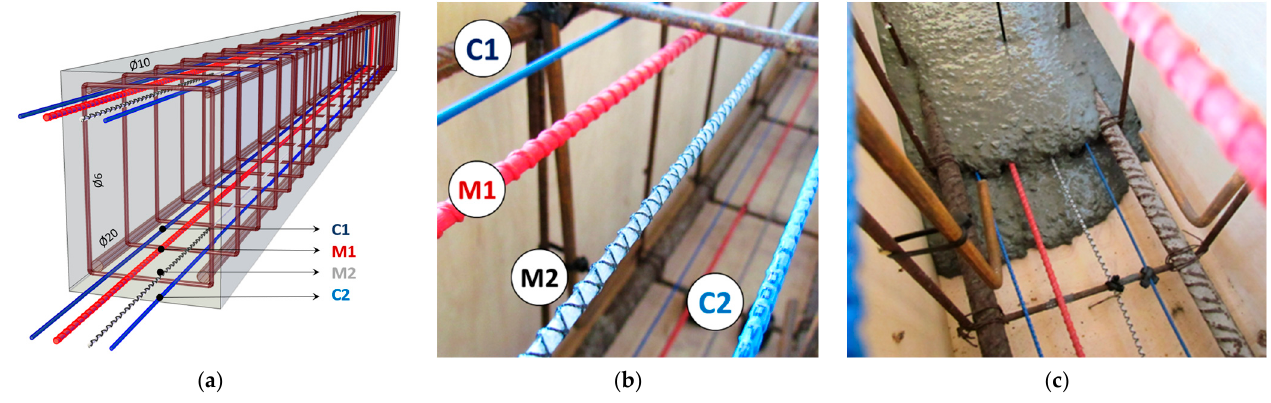
Figure 8. ( a ) Spatial visualisation of the reinforced concrete beam equipped with DFOS tools; ( b ) close- up to the selected tools; ( c ) the view of the beam during